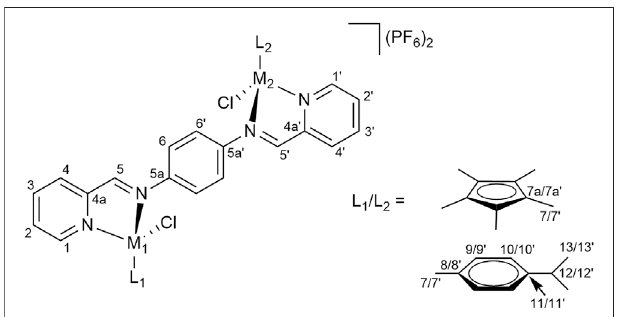
FIGURE 8 | NMR numbering scheme for complexes 2a – 2f .